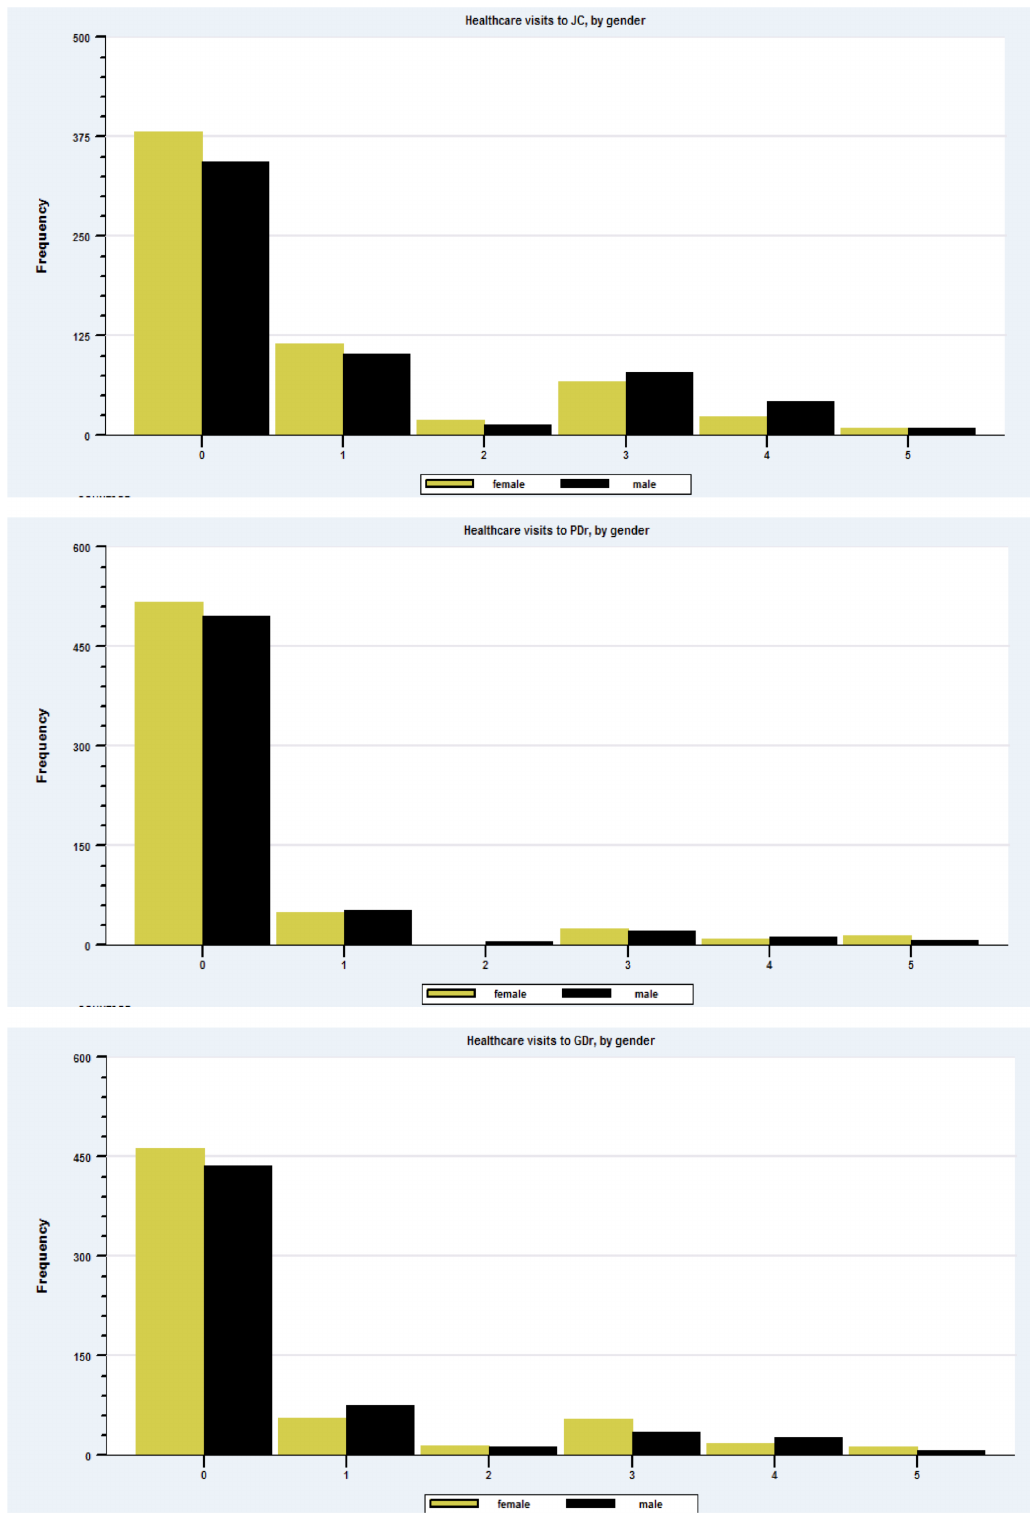
Fig 1. Frequency distribution of visits to healthcare providers for a single fever episode over 12-months.